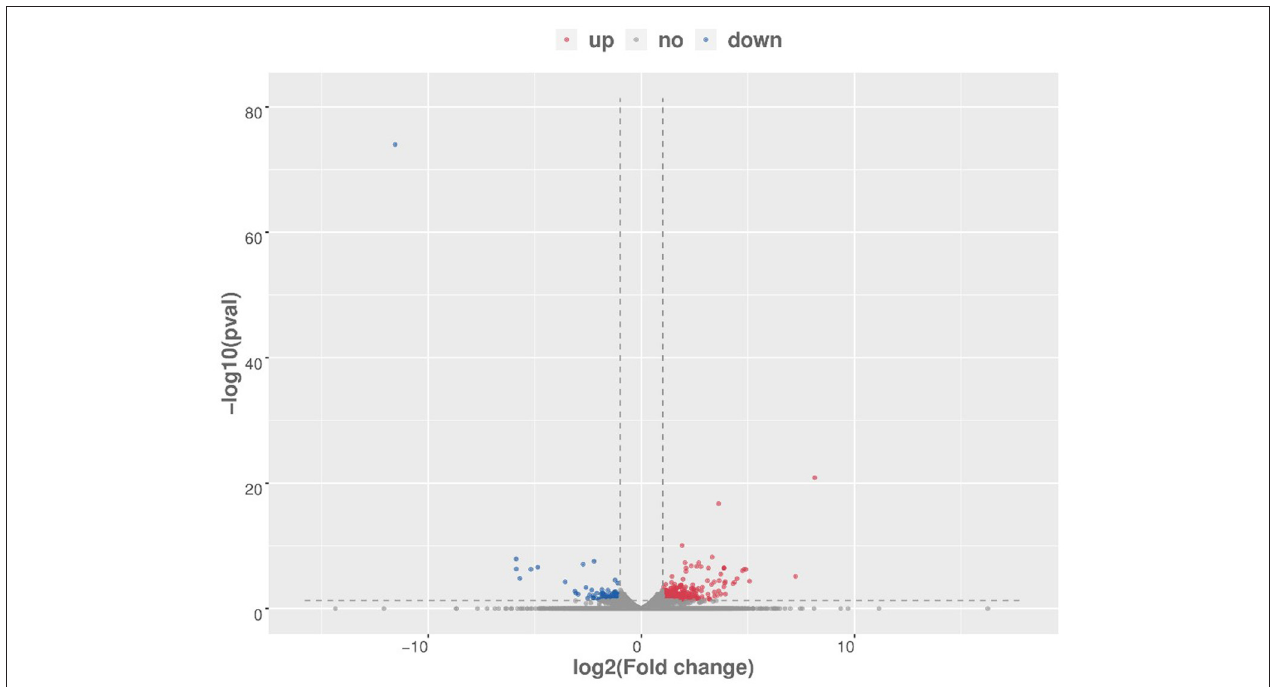
FIGURE 4 | Volcano map of differential genes (HD vs. CK). Red represents upregulated significantly differentially expressed genes, blue represents downregulated significantly differentially expressed genes, and gray dots represent non-significant differentially expressed genes. HD, High-dose group; CK, Control